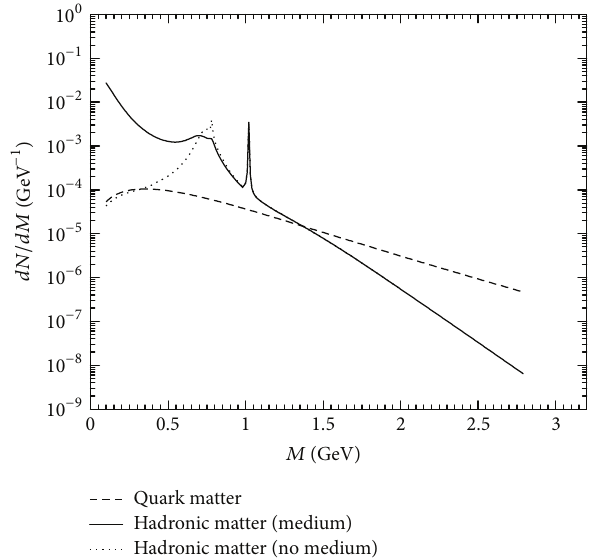
Figure 38: Invariant mass distribution of lepton pairs from quark matter and hadronic matter [13].